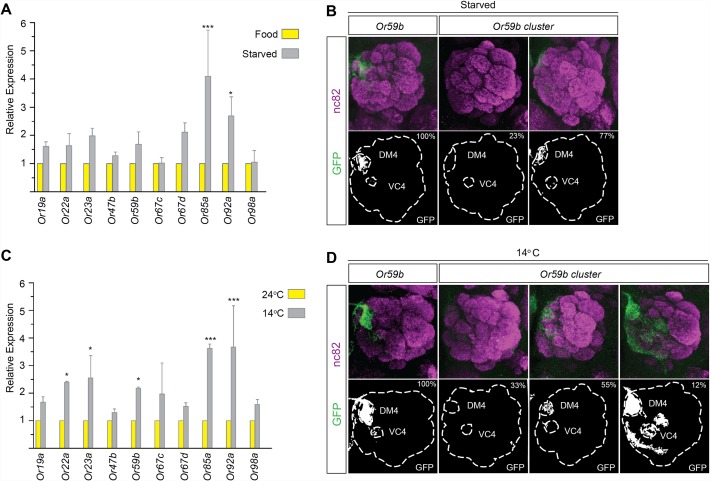
Temperature stress or starvation hampers Or59b cluster function.(A) Following 3 days of starvation, the mRNA levels of indicated OR genes were measured by qPCR and compared with control flies (* p < 0.05; ** p < 0.01; error bars represent SEM). (B) GFP expression (green) driven by the Or59b reporter or Or59b cluster following 3 days of starvation. Synaptic neuropil regions are labeled with the presynaptic marker nc82 (magenta). Phenotype penetrance is marked as a percentage at the top-right corner of the image. (C) Following 3 days at 14°C, the mRNA levels of the indicated ORs were measured by qPCR and compared with flies maintained at 24°C (* p < 0.05; ** p < 0.01; *** p < 0.001; error bars represent SEM). (D) GFP expression produced by the Or59b reporter and the Or59b cluster at 14°C. Note that the same insertion of the Or59b cluster construct produces both loss- and gain-of-expression phenotypes at 14°C. Schematic interpretations of the results are presented in S6 Fig.